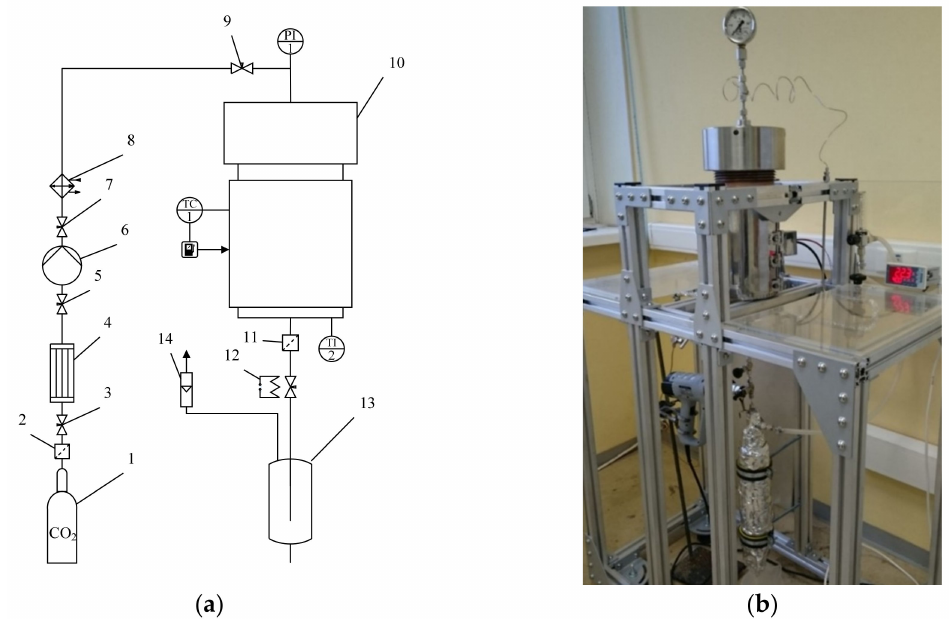
Figure 3. Supercritical drying experimental setup: ( a ) flowsheet of supercritical drying experimental setup: 1—vessel with liquid CO 2 (60 bar); 2, 11—micro filters; 3, 5, 7, 9—needle